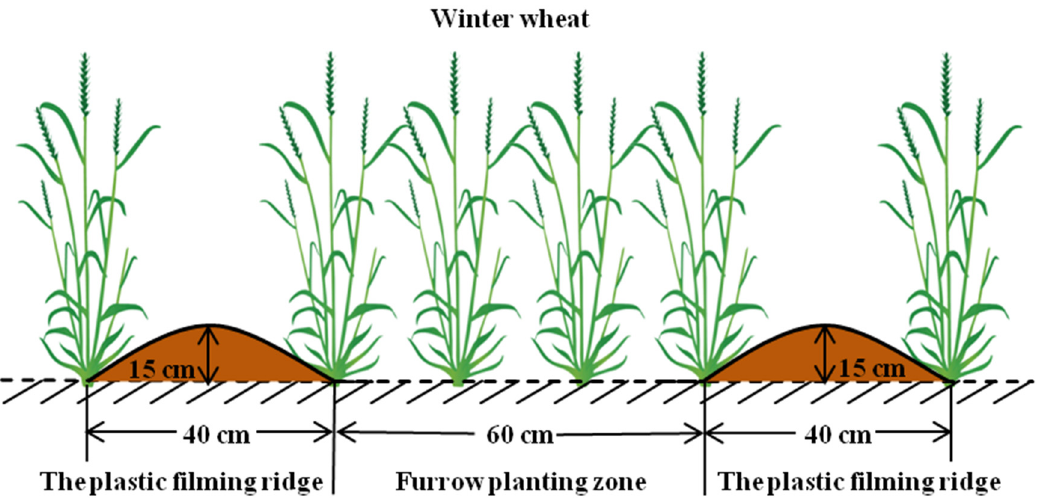
Figure 2. Schematic diagram of the ridge–furrow rainwater harvesting (RFRH) planting mode.